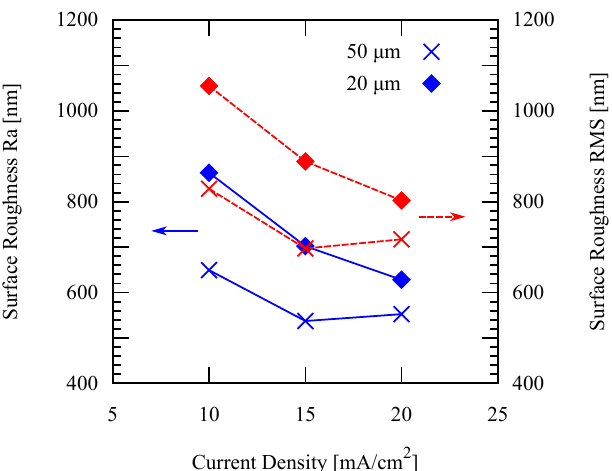
Figure 11. Surface roughness of the resulting deposits using different current densities applied with different pattern widths.